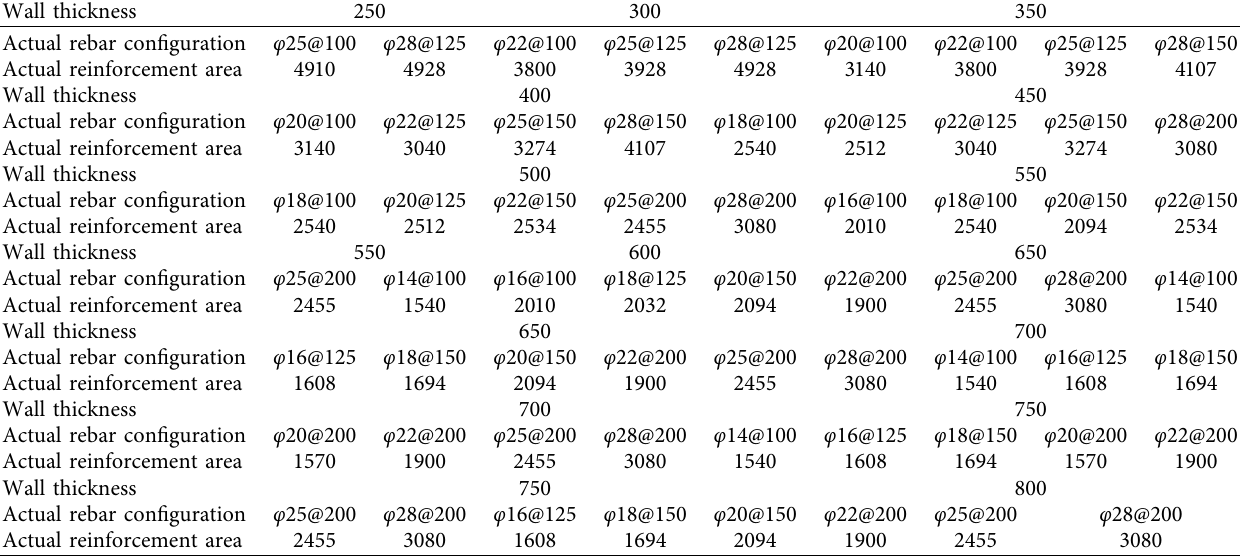
Table 3: Rebar configurations of different wall thicknesses.